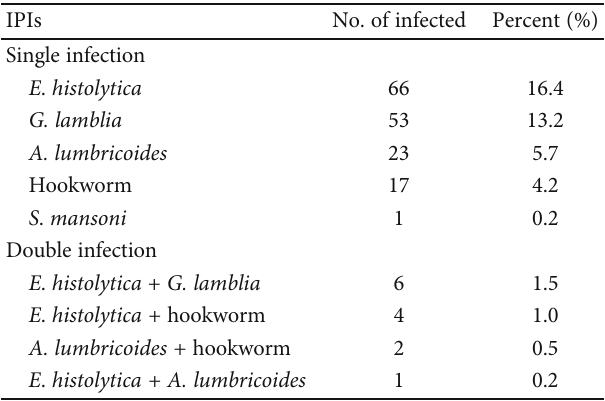
Table 2: The prevalence of HIPIs among elementary school children in Merawi town, from March to April